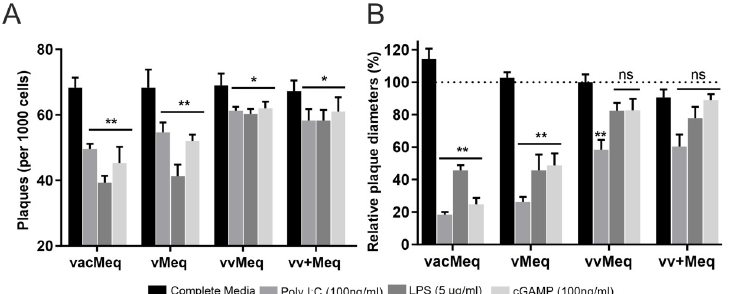
Fig 5. Efficiency of meq isoform viruses to overcome innate immune responses. Primary T cells were activated by innate immunity agonists (Poly I:C, LPS, or cGAMP). Activated T cells were infected with the different meq isoform viruses to determine the effects on virus shedding and replication. (A) Plaque counts were performed on CEC overlaid with 1,000 activated infected primary T cells. (B) Corresponding changes in plaque sizes on infected CEC (normalized to vvMeq). Asterisks indicate significant differences ( � p < 0.05 and �� p < 0.0125; Tukey’s multiple comparisons test).